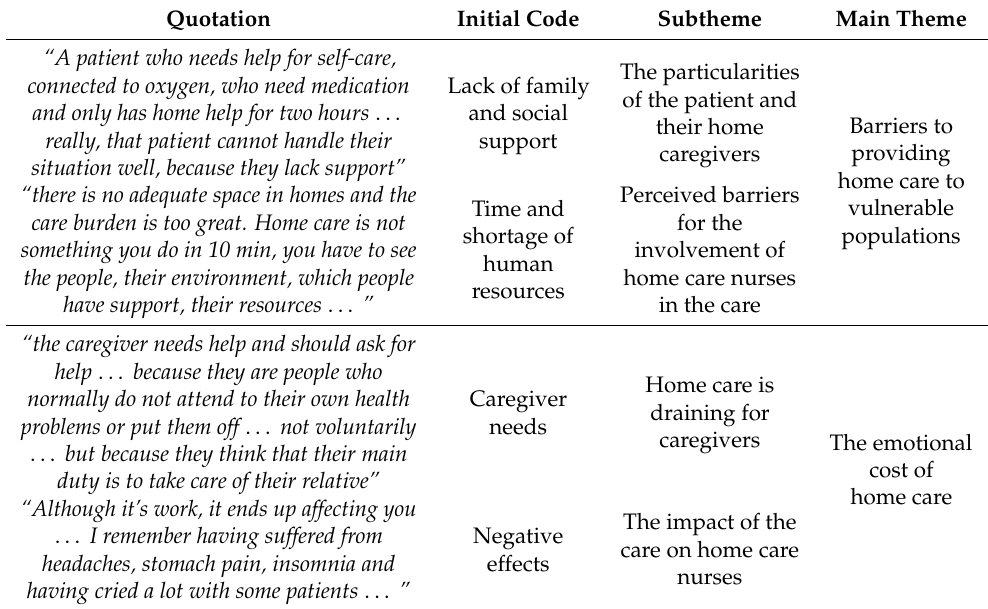
Table 3. Examples of coding